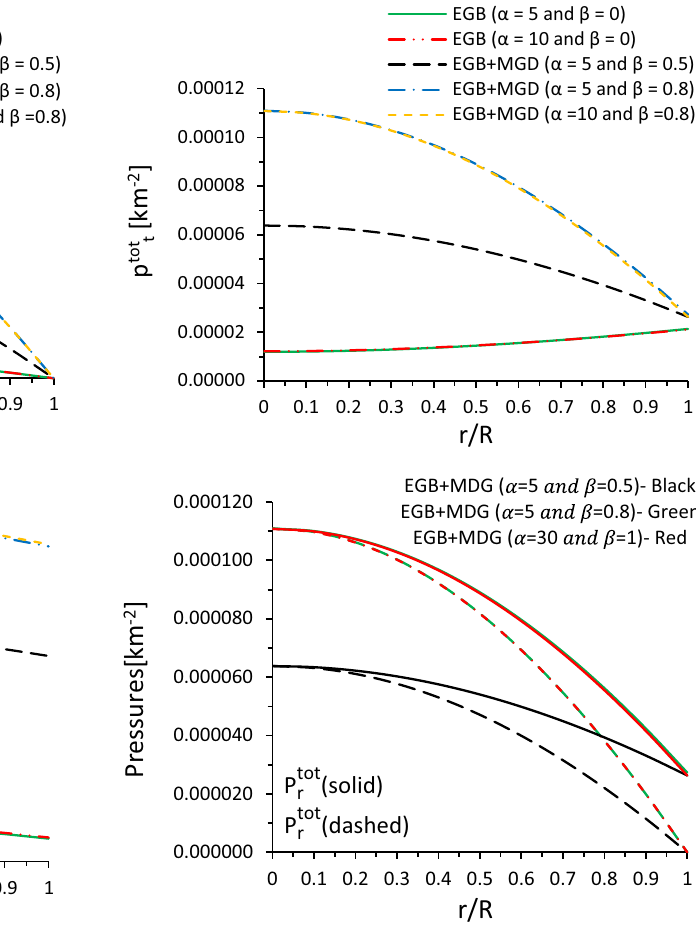
Fig. 4 Top panels : the left panel shows the total radial pressure ( p tot r ) andtherightpanelshowsthetotaltangentialpressure( p tot t )withrespect to the radial coordinate r / R . Bottom panels : The left panel represents